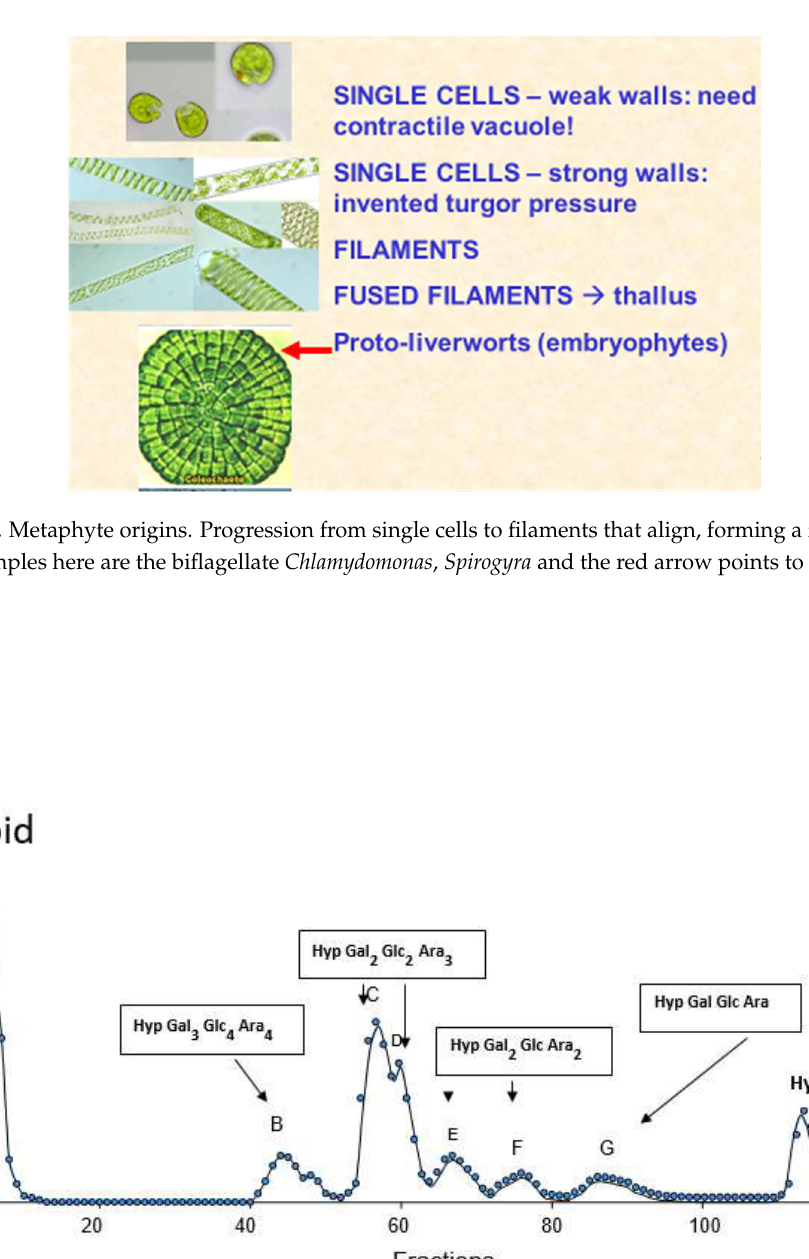
Figure 10. Coleochaete hydroxyproline glycosides. Alkaline hydrolysates of Coleochaete scutata cell walls fractionated on a cation exchange column gave a Hyp-glycoside profile that appeared similar to the profile of cell walls isolated from higher plants. However, closer inspection and quantitative sugar analyses showed a striking difference; in higher plants, the Hyp-glycosides are simple arabinosides, whereas Coleochaete shows heterooligosaccharides of up to seven sugar residues that include galactose, glucose and arabinose, compositions remarkably similar to the profile of cell walls isolated from Chlamydomonas [119] but different from other members of the plant kingdom [120]. Presented at the 11th Cell Wall Meeting, Copenhagen [121].